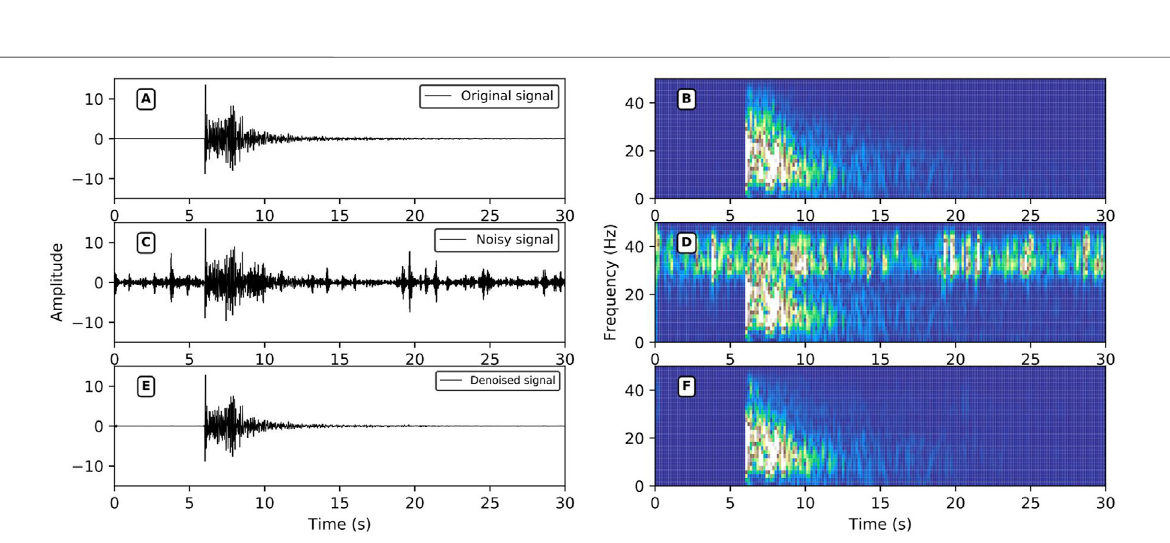
Frontiers in Earth Science |